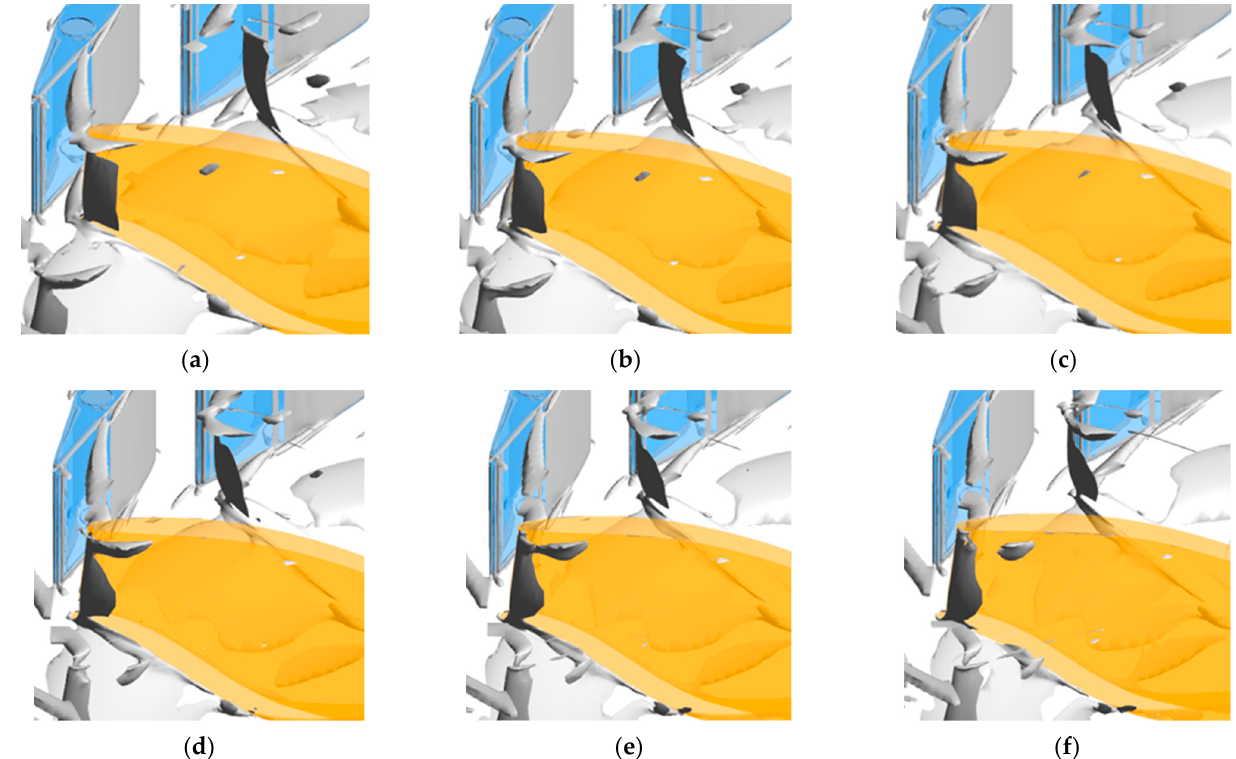
Figure 12. Progression of leakage vortex during runner rotation at part load: ( a ) T 0 ; ( b ) T 0 + 1/5 of X°; ( c ) T 0 + 2/5 of X°; ( d ) T 0 + 3/5 of X°; ( e ) T 0 + 4/5 of X°; ( f ) T 0 + X°.